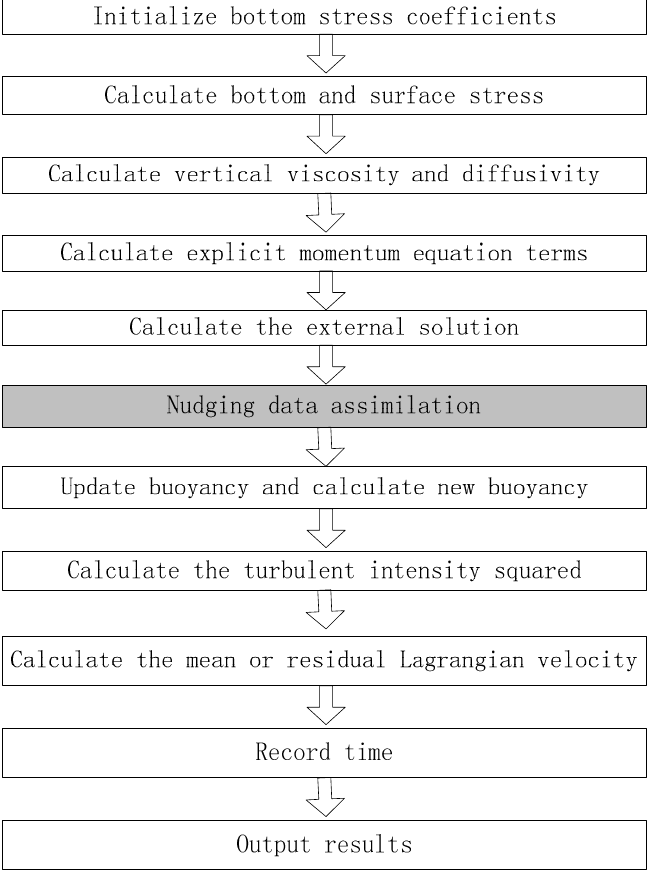
Figure 3. Flowchart of data assimilation in main program HDMT.FOR of EFDC (shaded part indicates new subroutine for data assimilation).